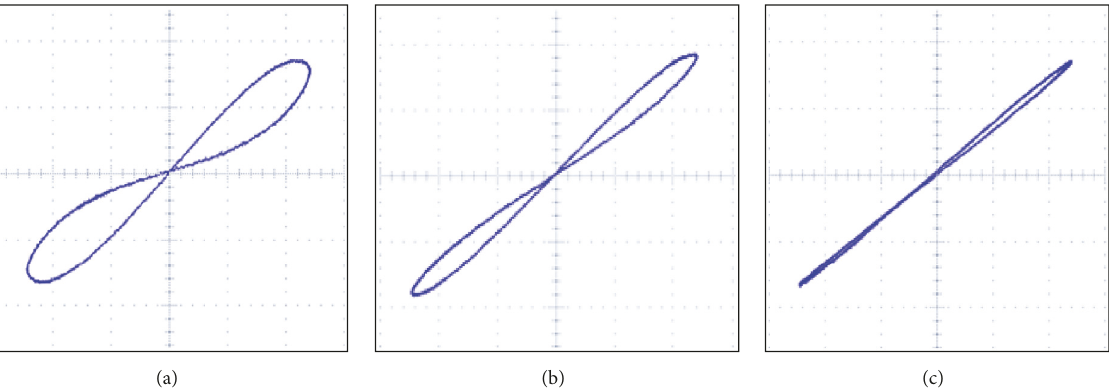
Figure 8: Experimental results of the incremental type emulator when 𝐶 1 = 𝐶 2 = 1 nF. (a), (b), and (c) represent hysteresis loops in V - 𝑖 plane operating at 1kHz, 5 kHz, and 10kHz, respectively. The scales are 0.2 V/div for 𝑥 -axis and 0.2 V/div for 𝑦 -axis.